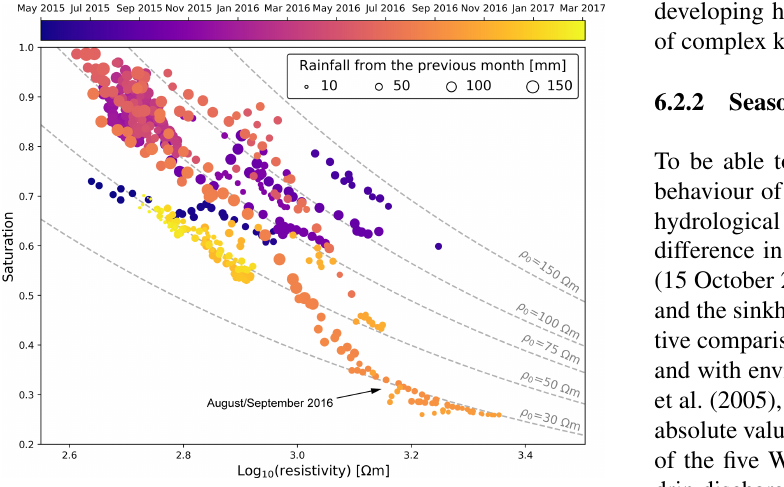
Figure 12. Relationship between the resistivity (median) of the sur- face limestone region and the saturation from the 10cm deep WCR data. Theoretical relationships derived from Archie’s law with suc- cessive pore-water conductivity values are displayed as watermarks (Archie’s cementation and saturation parameters are set to 1.5 and 2